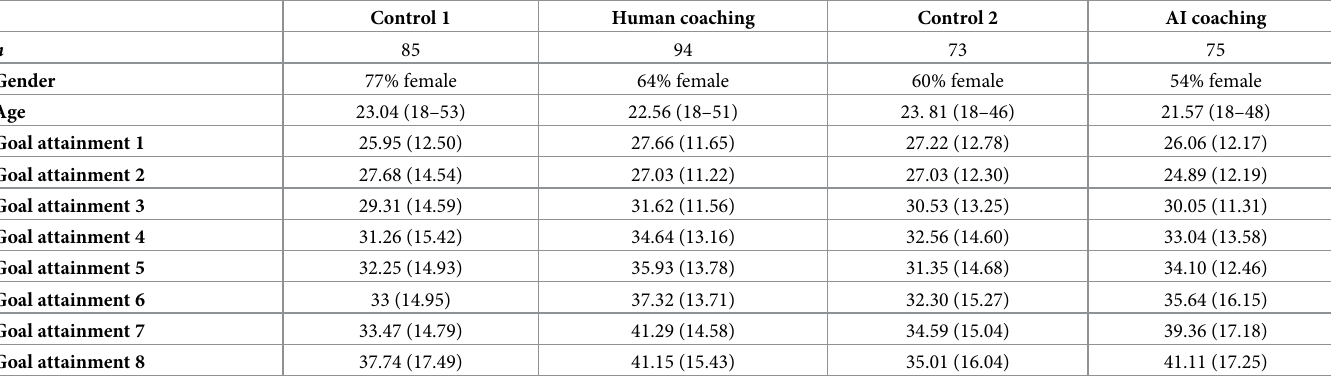
Table 2. Goal attainment means of the four participant groups across the eight time-points. Control